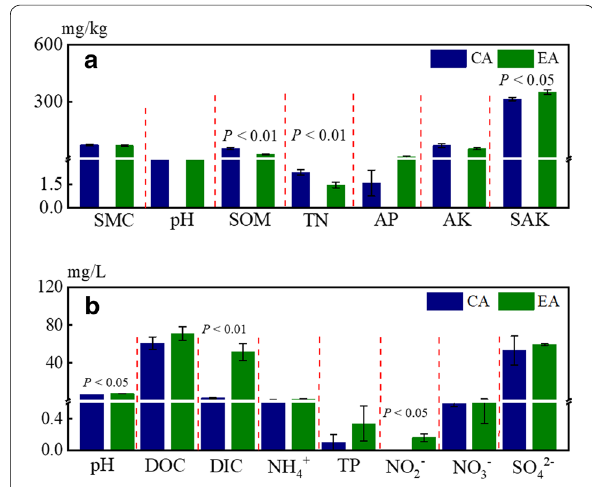
Fig. 2 Physical–chemical characteristics of rice soil ( a ) and its pore water (PW) ( b ) between CA and EA. CA conventional agriculture, EA ecological agriculture, SMC soil moisture content, TN soil total